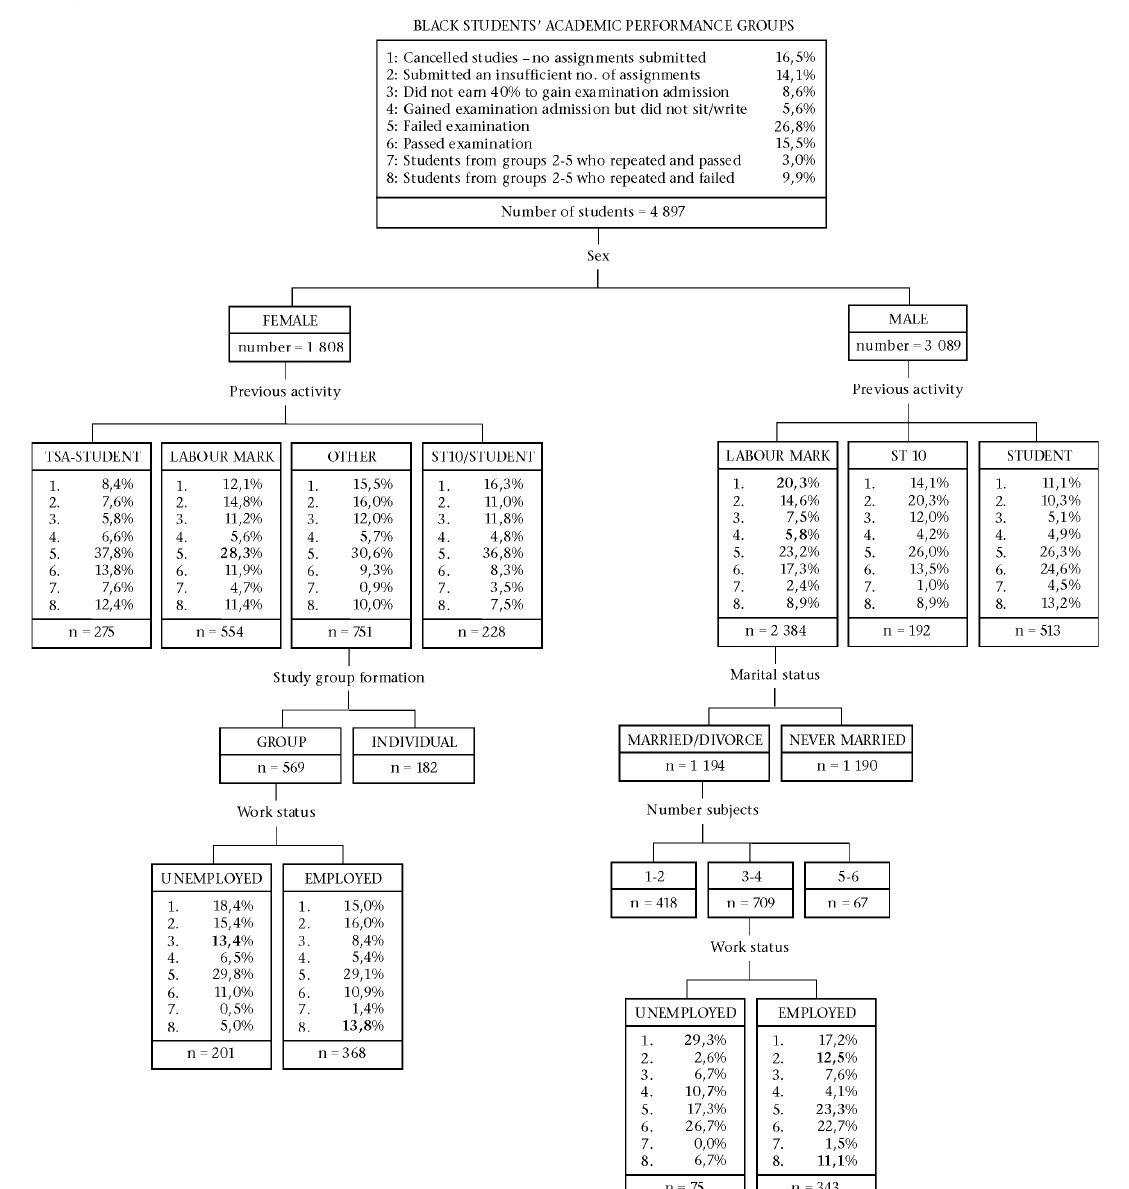
Figure 5: Dendogram of the black student